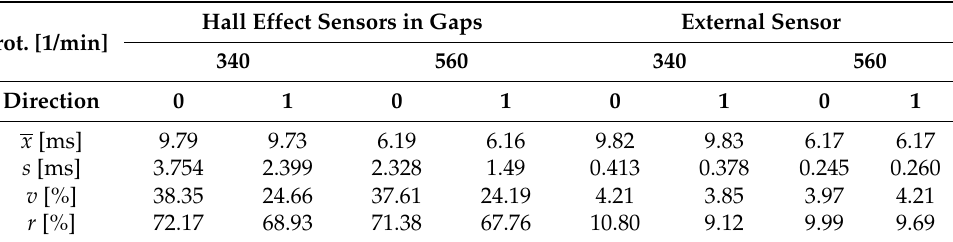
Table 3. Comparison of the symmetry of the signal determining the state of the rotor position for the hall effectors inside the engine and for the external sensor in the case of driving the engine. rot. [1/min]